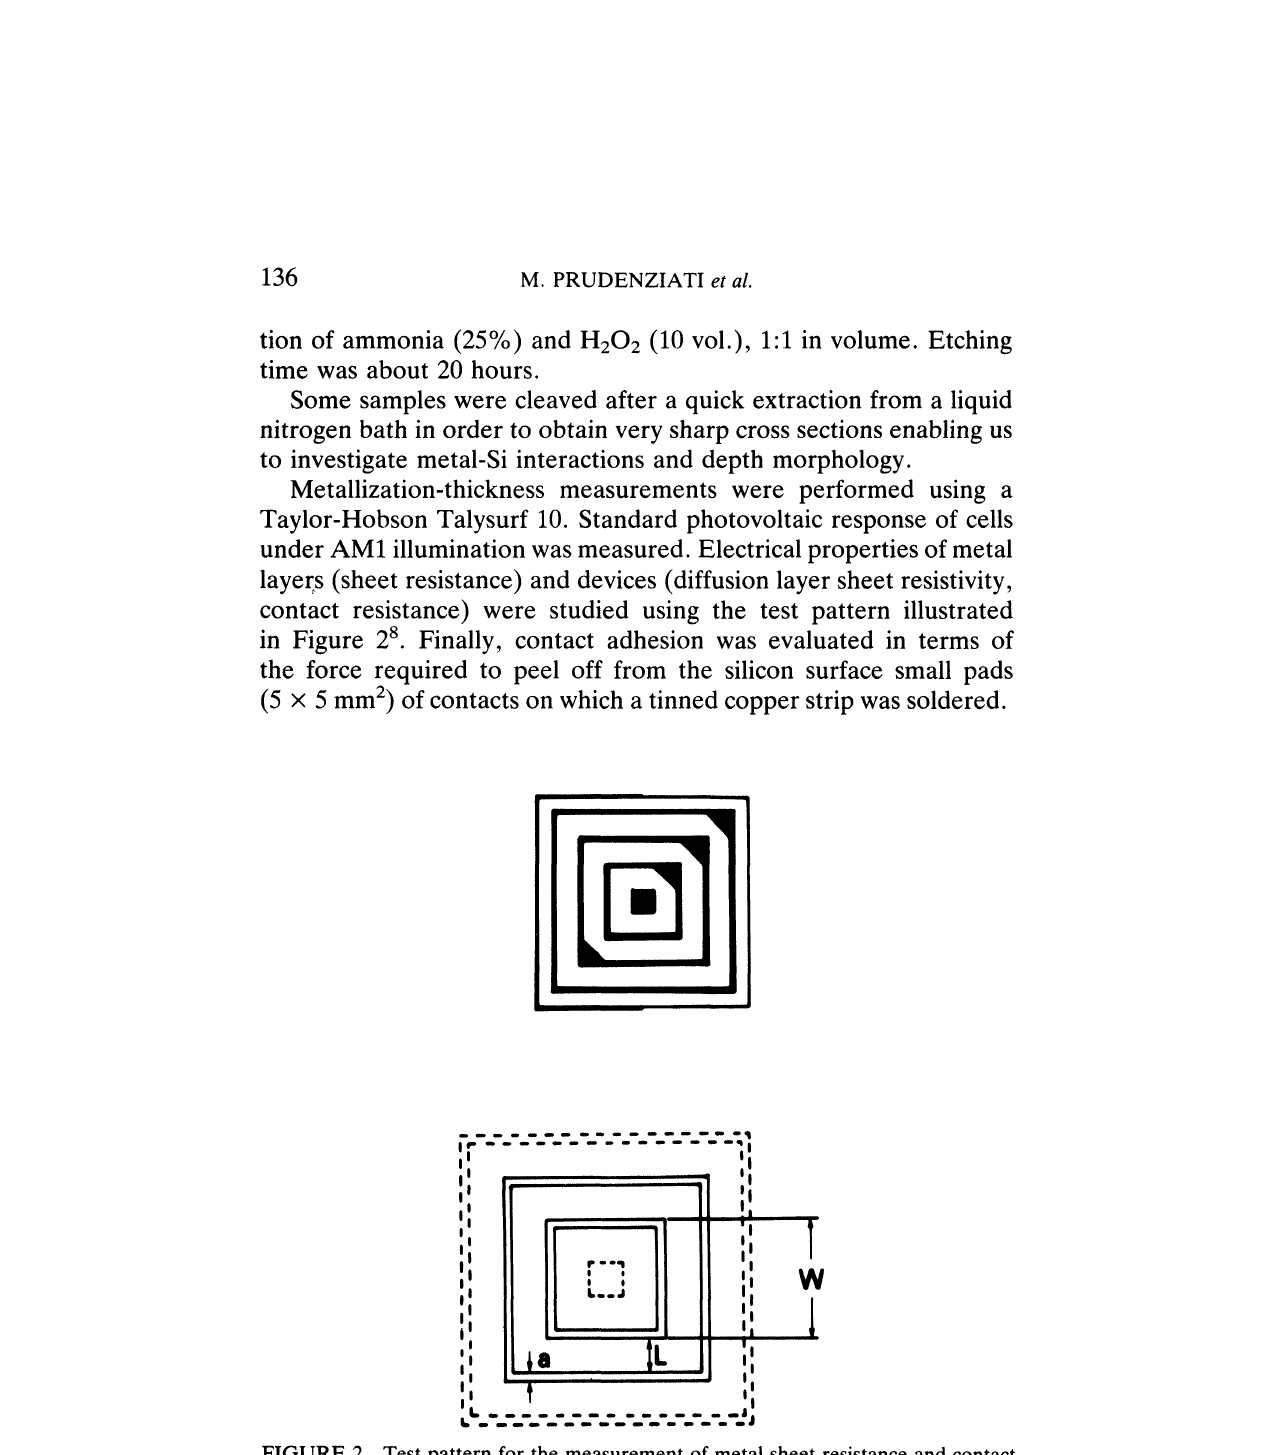
FIGURE 2 Test pattern for the measurement of metal sheet resistance and contact resistance; d 0.25 mm, L 0.90 mm, W 2.8